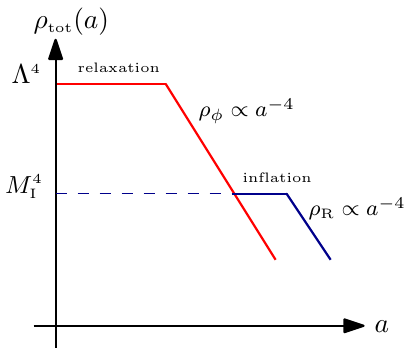
Figure 39 . Sketch of the energy density of the universe as a function of the scale factor in the scenario where the relaxion drives an in(cid:13)ationary